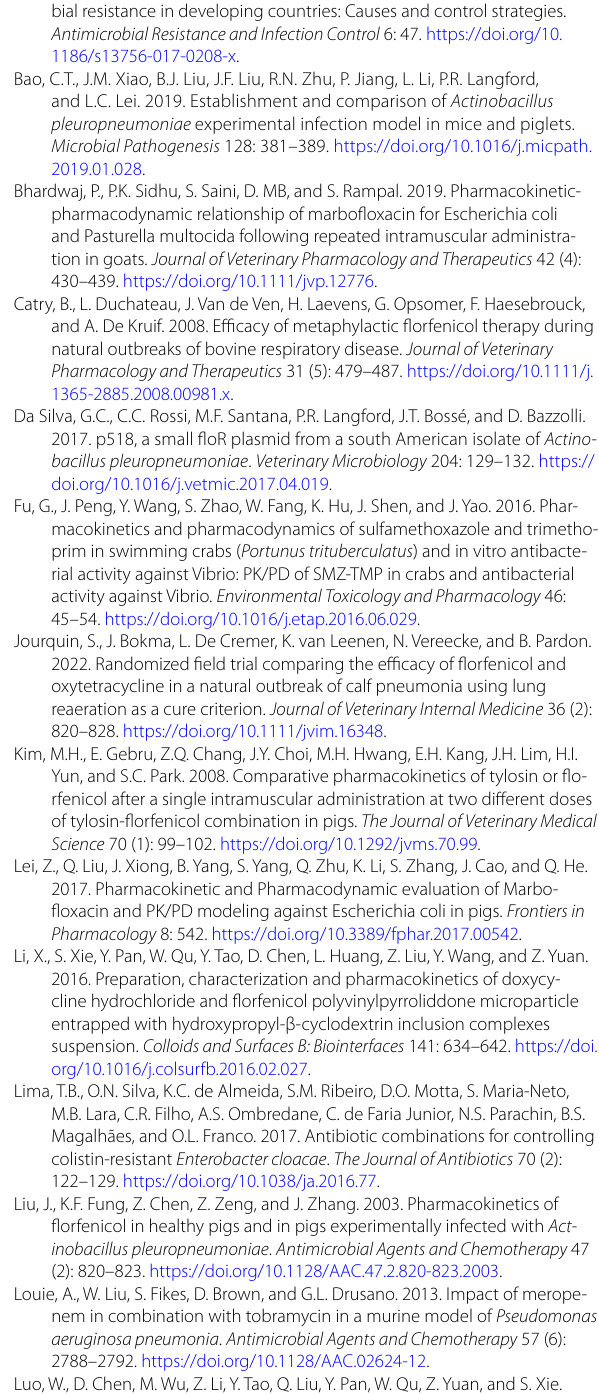
and FF against APP. Supplementary Table 3. Checkerboard method for combinations of Drugs A and B. Supplementary Table 4.